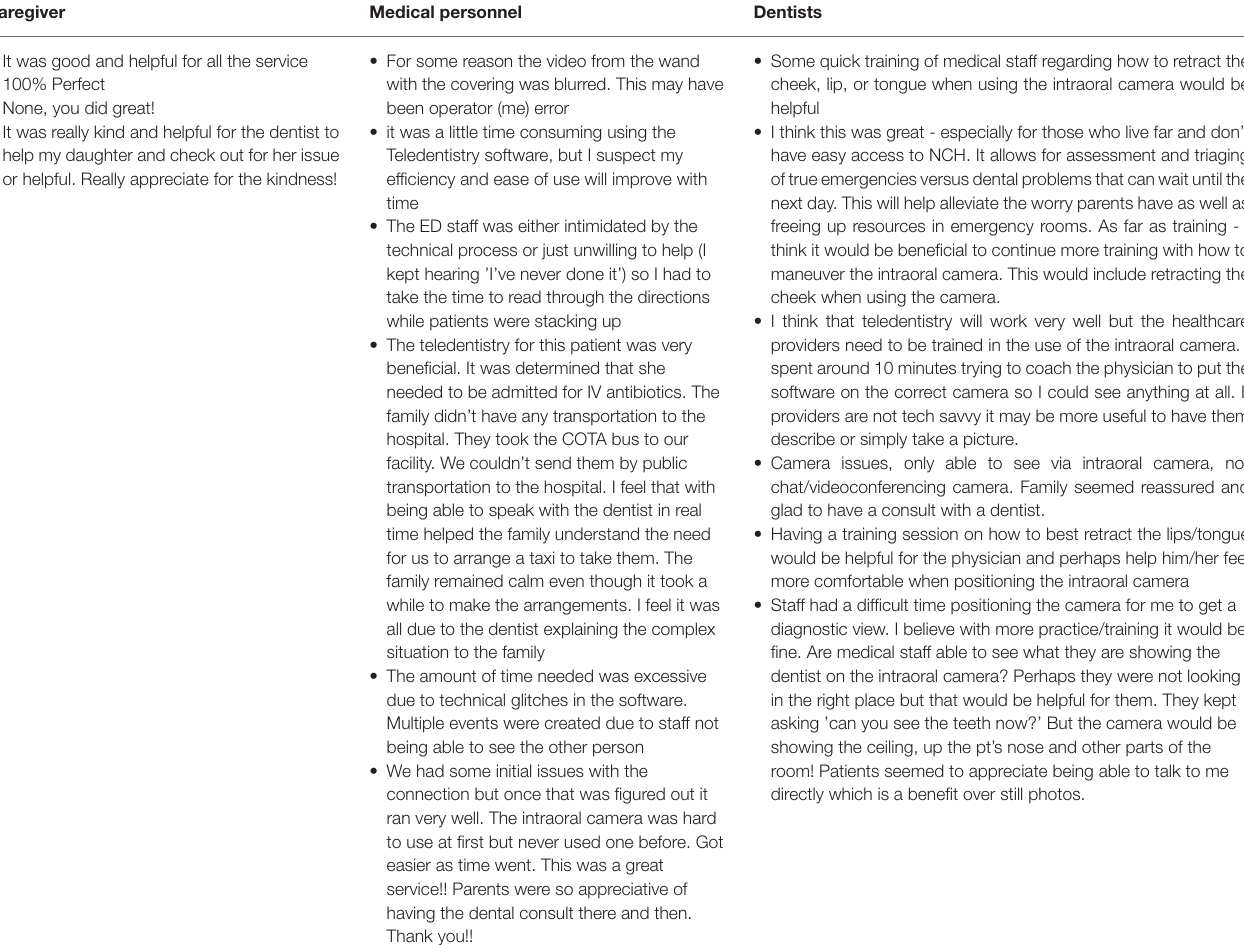
TABLE 3 | Comments from caregivers, medical personnel, and dentists.